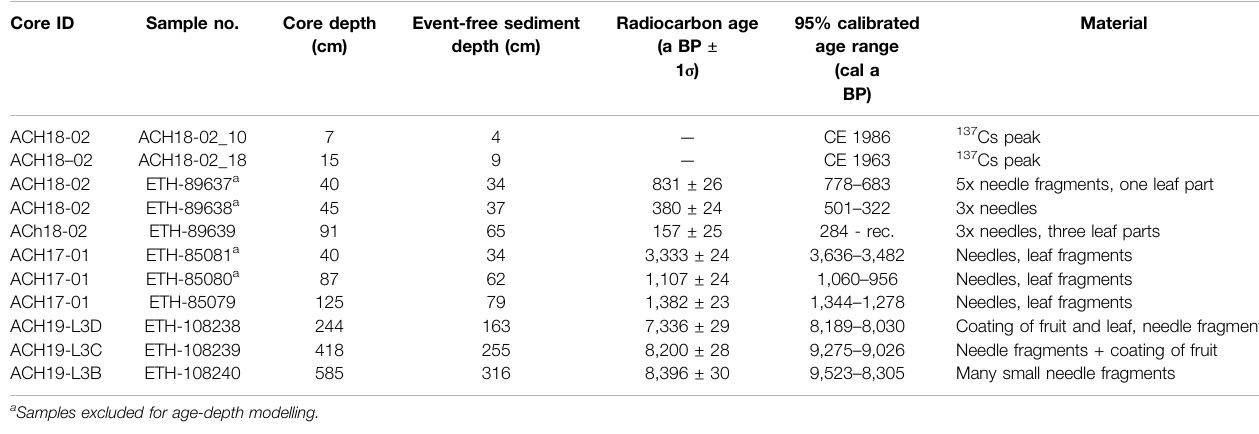
TABLE 2 | Radiocarbon ages of core ACH19-L3.